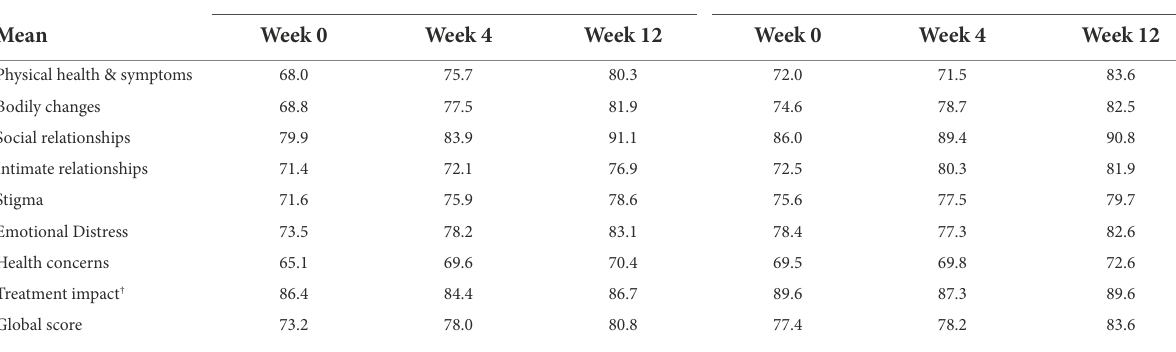
TABLE 3 Mean PROQOL-HIV/TB sub-scores in the prednisone and placebo arm. Prednisone